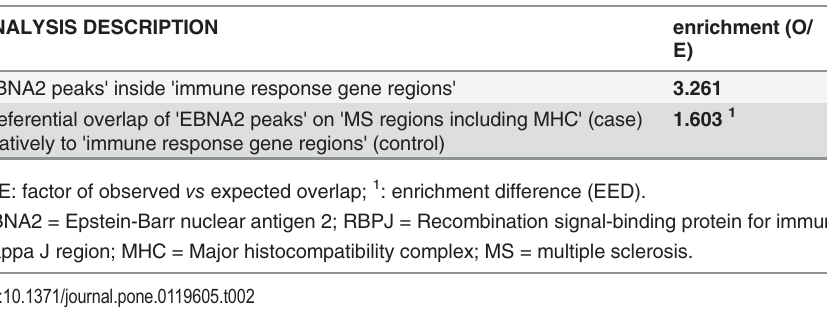
Table 2. EBNA2 peak overlap with immune response gene regions and excess enrichment of case- control